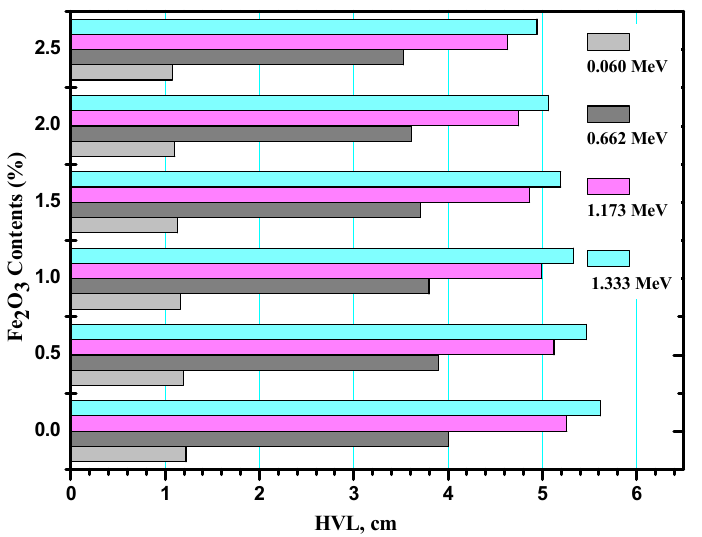
Figure 7. The relation between the HVL and the concentrations of Fe 2 O 3 nanoparticles at different energies. The radiation attenuation competences of the tested mortars have been examined in the context of the tenth value layer (TVL). The experimental results for the TVL have been graphed in Figure 8. According to the data given in this figure, the thinnest TVL and thus the superior radiation shielding competence (3.56, 11.69, 15.36, and 16.40 cm at the selected energies) have been found for the mortar with 25% of Fe 2 O 3 nanoparticles. Additionally, the TVL values of the reference mortar were higher than the values predicted for all mortars with 2–25% of Fe 2 O 3 nanoparticles. According to the TVL results, we can develop new mortars for radiation shielding applications by introducing Fe 2 O 3 nanoparticles.